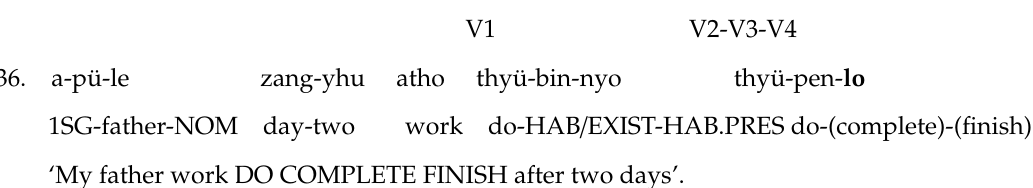
Table 6. Tense – aspect – m ood in Rengma.